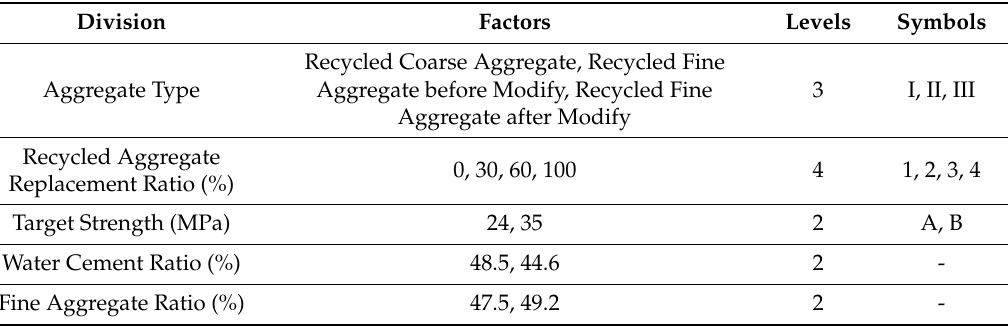
Table 3. Experimental factors and levels.